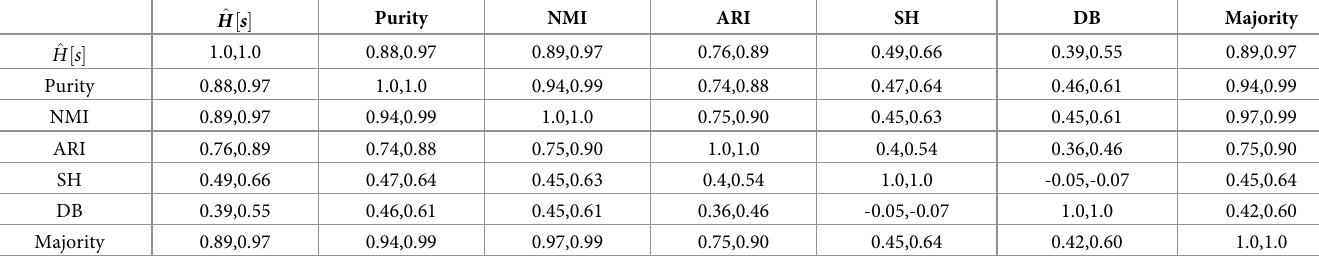
Table 12. Kendall’s τ and Spearman’s correlation result for